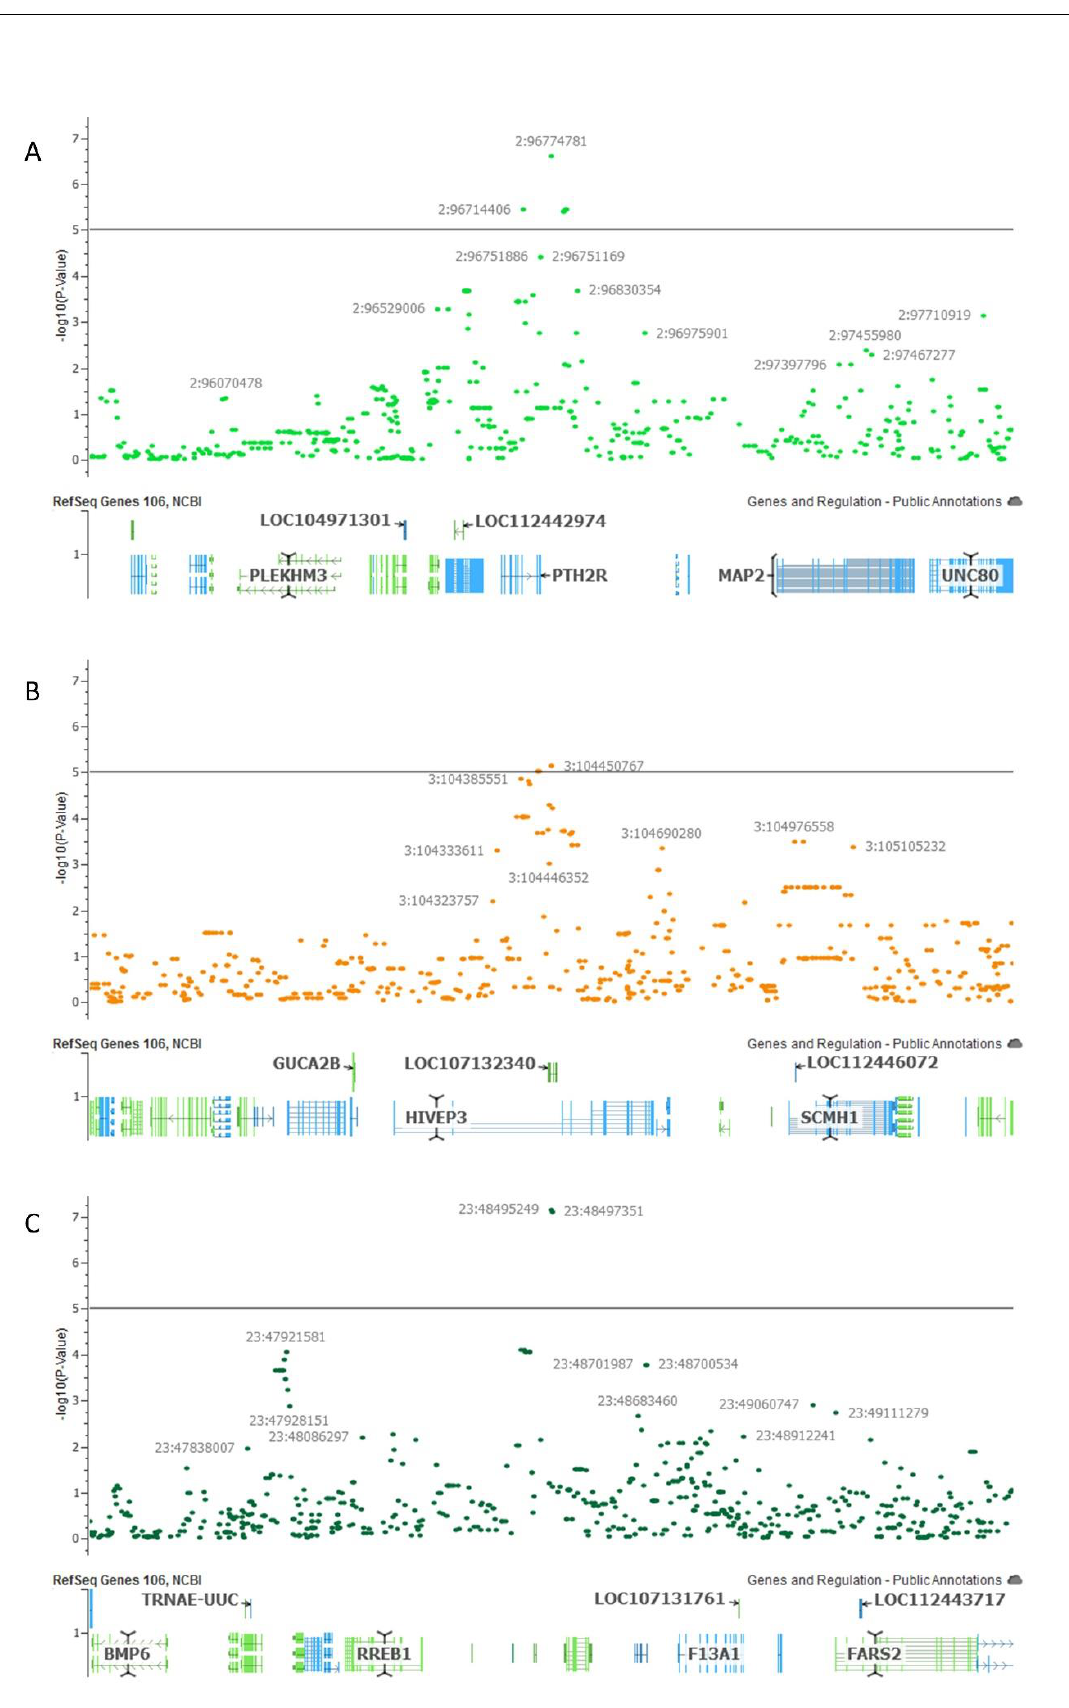
Figure 3. Regions within 1 Mbp of the most significant SNP for the antral follicle count GWAS results for ( A ) chromosome 2; ( B ) chromosome 3; ( C ) chromosome 23.